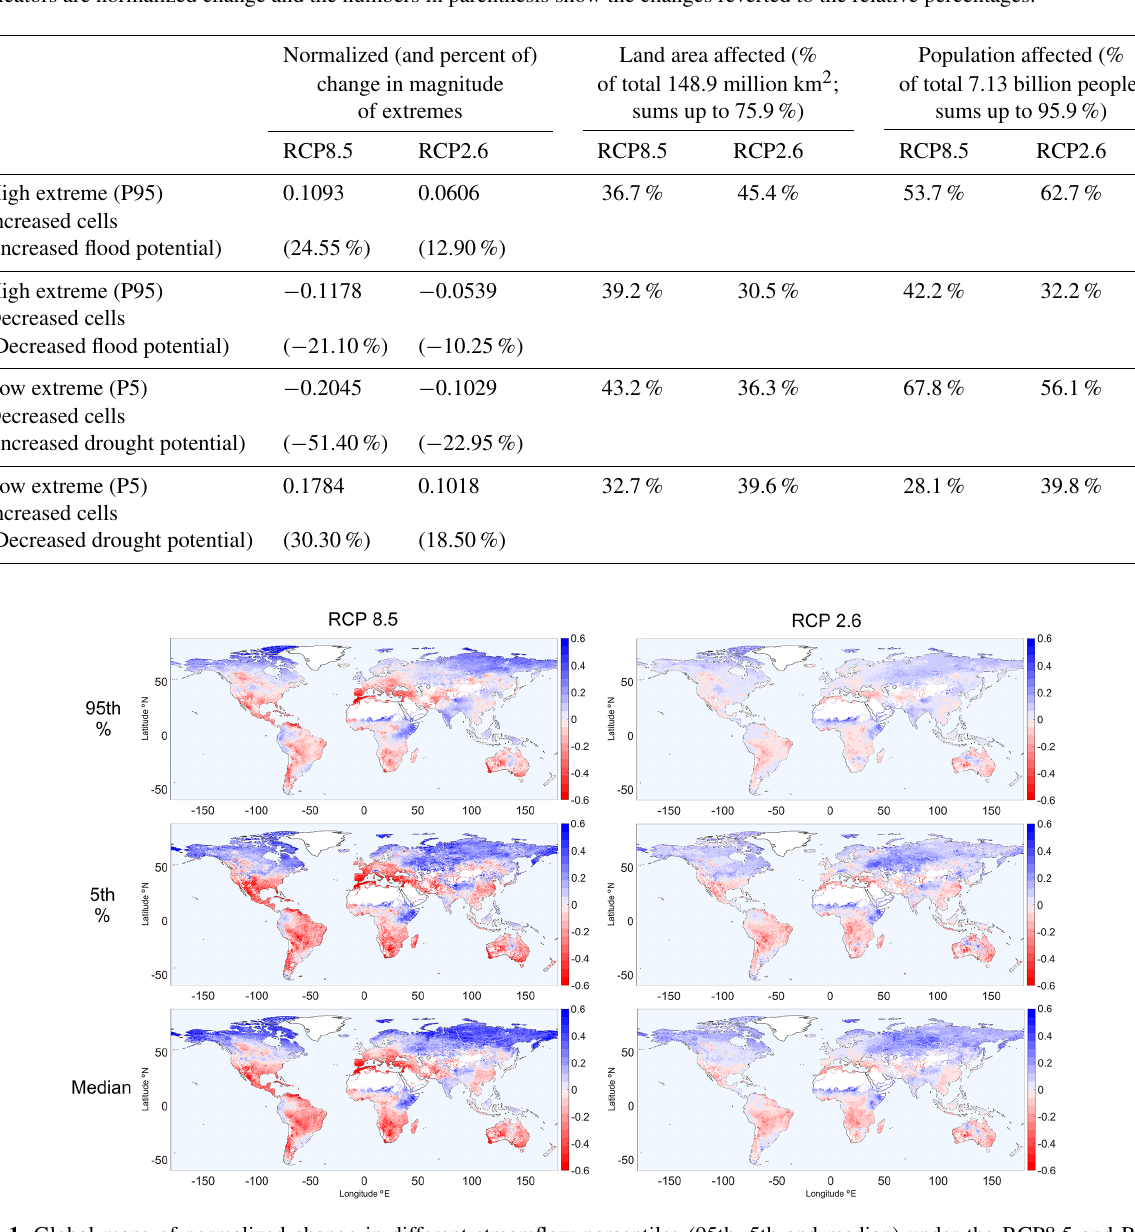
Table 1. Multi-model average change in high and low streamflow extremes, as well as the percent of population and land area affected by each category, for the RCP2.6 and RCP8.5 scenarios. Presented percentages are for total global land area and total global population, and sum up to the 75.9% of global land area and 95.9% of the year 2015 total global population considered in this study. The values of change for indicators are normalized change and the numbers in parenthesis show the changes reverted to the relative percentages.